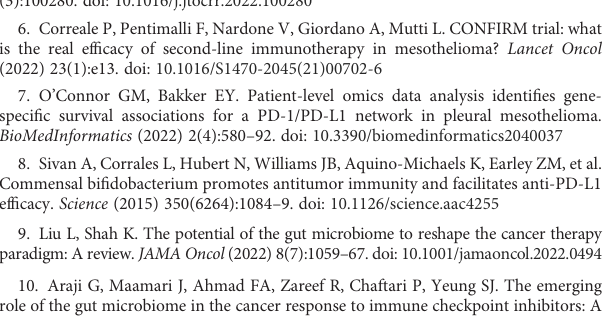
SUPPLEMENTARY FIGURE 7 Comparison of histological subtype between “ High Survivors ” and “ Low Survivors ” . Note that per the World Health Organization (https://apps.who. int/iris/bitstream/handle/10665/96612/9789241548496_eng.pdf), 9050/3 refers to “ Mesothelioma, malignant, NOS ” , 9052/3 to “ Epithelioid mesothelioma, malignant, NOS ” , and 9053/3 to “ Mesothelioma, biphasic, malignant, NOS ” . SUPPLEMENTARY FILE 1 Excel fi le of DEGs and DAVID analysis. SUPPLEMENTARY FILE 2 Excel fi le of multiple linear regression inputs and iterations, as well as clinical data for the patients. SUPPLEMENTARY FILE 3 Excel fi le of microbiome abundance analysis based on patient subdivision by malignancy SUPPLEMENTARY FILE 4 Excel fi le of differentially expressed genes mapped to genes involved in either immune in fi ltration and in fl ammation (per GeneCards (55,